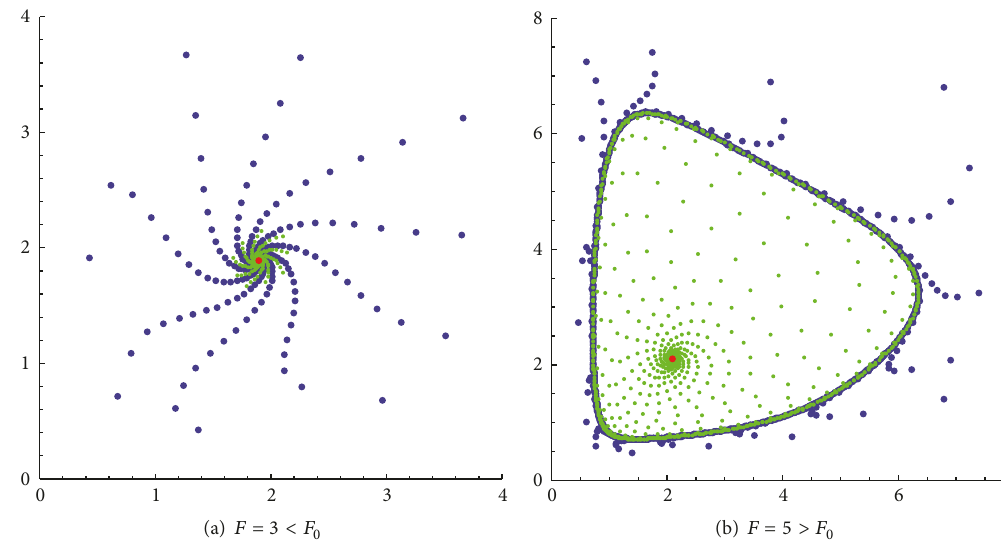
Figure 11: Phase portraits when 𝑐 = 1,𝑏 = 0.5, 𝐵 = 2 , 𝑥 −1 = 𝑥 0 = 2.1 (green), and 𝑥 −1 = 𝑥 0 = 6.8 (blue), generated by Dynamica 4